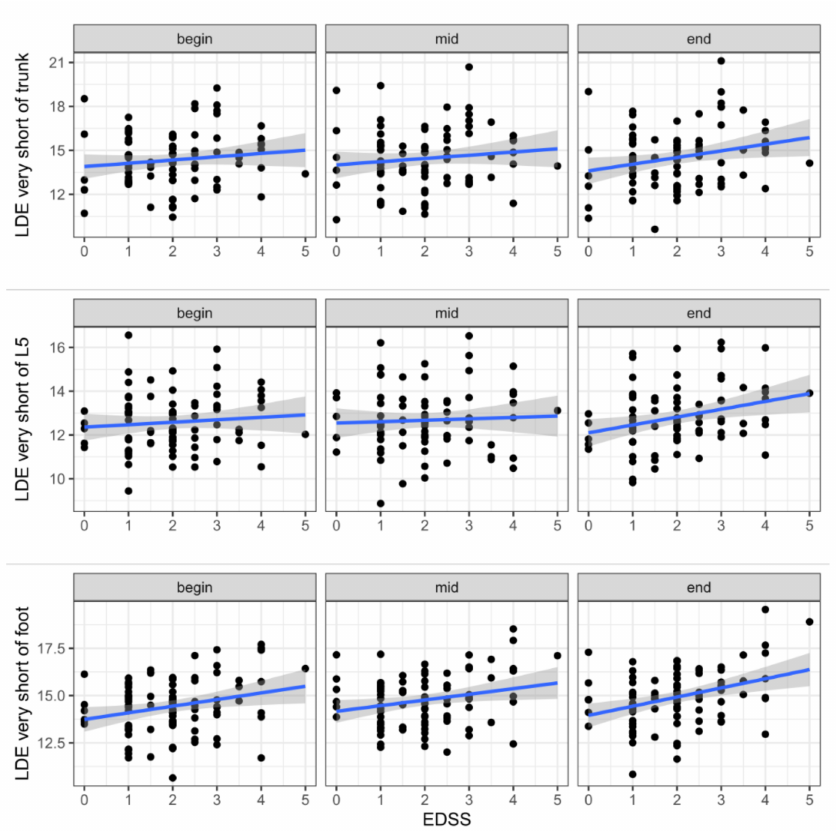
Figure 3. Changes of LDE very short over different levels of EDSS, calculated for the remaining first 30 (begin), middle 30 (mid) and last 30 strides (end) during a 6-min 25-ft walk and separated for the foot, lumbar spine (L5), and trunk